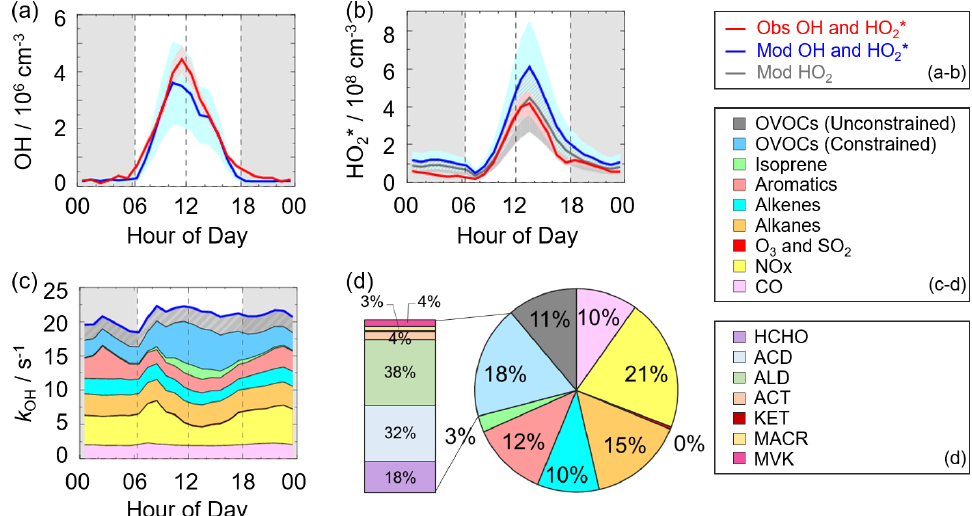
, and HO 2 concentrations. (c) The diurnal profiles of the 2 concentrations, and the dark 2